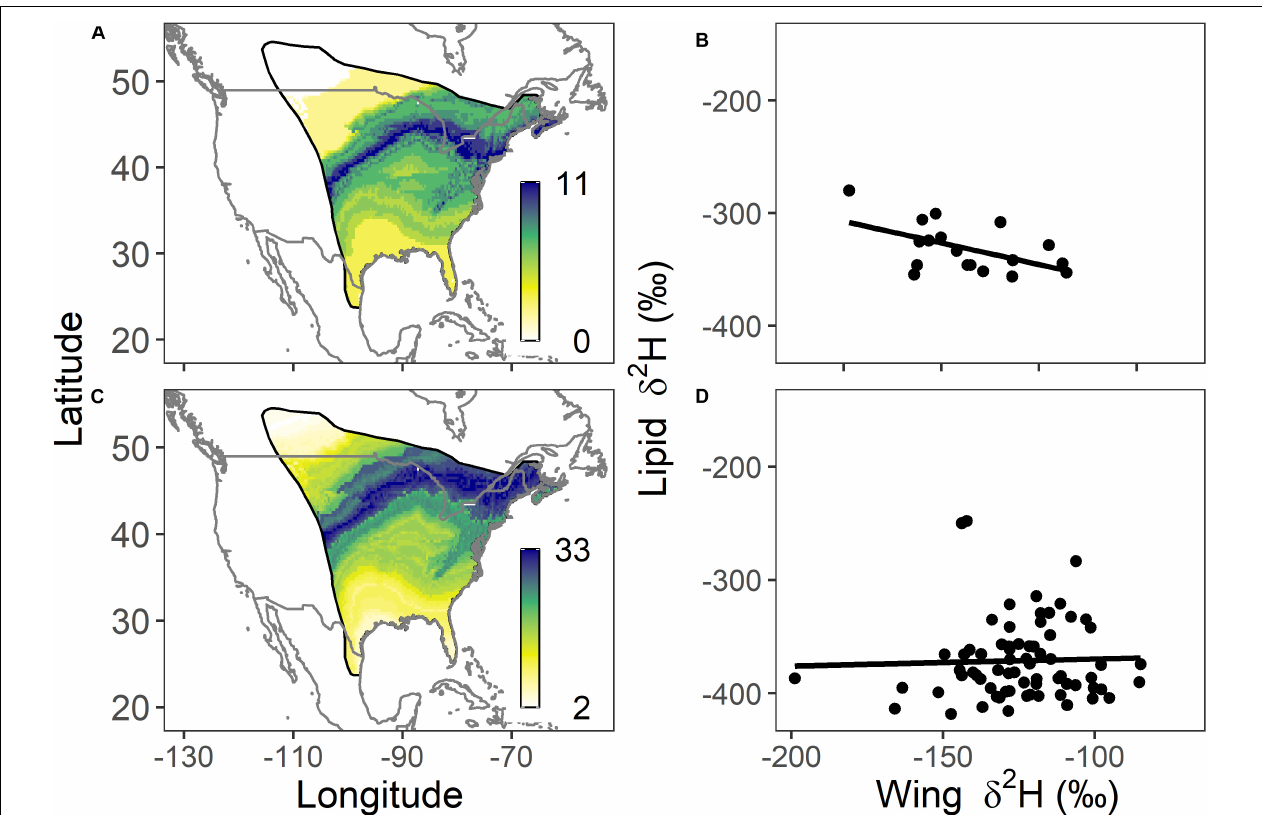
FIGURE 4 | Depictions of potential natal locations and the relationship between lipid δ 2 H and wing δ 2 H for monarchs sampled at overwintering sites in 2015–2016: Cerro Pelon n = 25 (A,B) and Sierra Chincua n = 19; El Rosario n = 19; Piedra Herrada n = 28 (C,D) . The legend represents the number of individuals at each pixel with wing δ 2 H values consistent with those predicted for that location based on a 2:1 odds ratio.